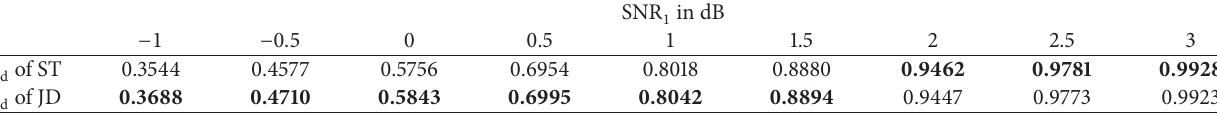
Table 1: Detection probability as a function of SNR 1 using (20).